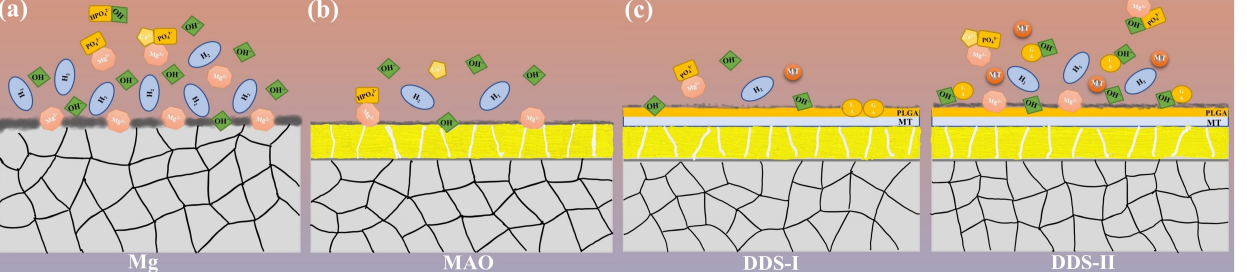
Figure 12. The degradation process and the release of Mg 2+ and MT of Mg alloy ( a ), Mg-based-MAO alloy ( b ), and Mg-based MAO-MT-PLGA DDS ( c